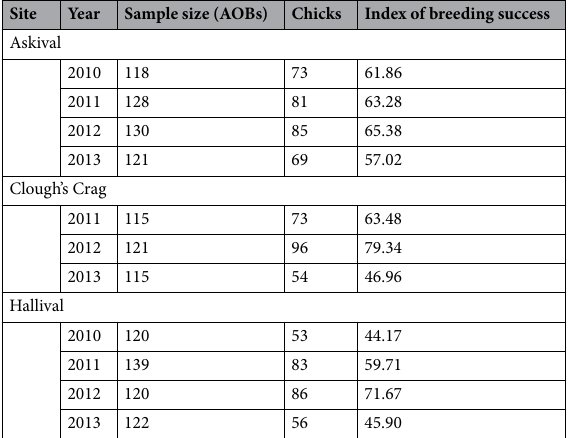
Table 3. Indices of Manx shearwater breeding success at three study sites on the Island of Rum between 2010 and 2013. Apparently Occupied Burrows (AOBs) were checked by endoscopy in early summer and then again in late